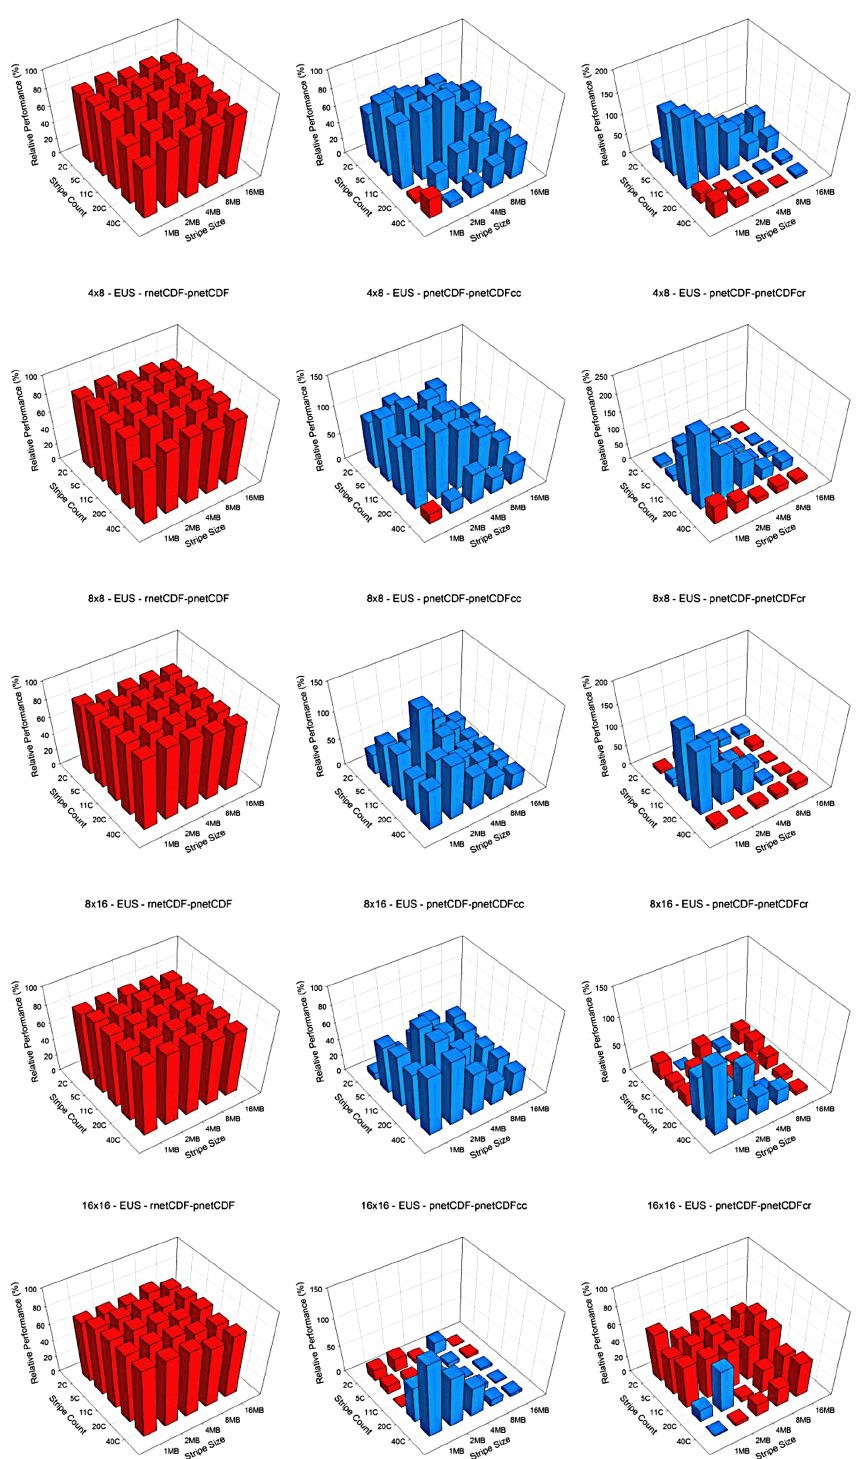
Figure 5. Relative I/O performance of pnetCDF to rnetCDF, and pnetCDFcc and pnetCDFcr to pnetCDF on the EUS domain with 4 × 4, 4 × 8, 8 × 8, 8 × 16, and 16 × 16 processor configurations from Kraken. Red color denotes positive value in relative performance while blue color denotes negative value in relative